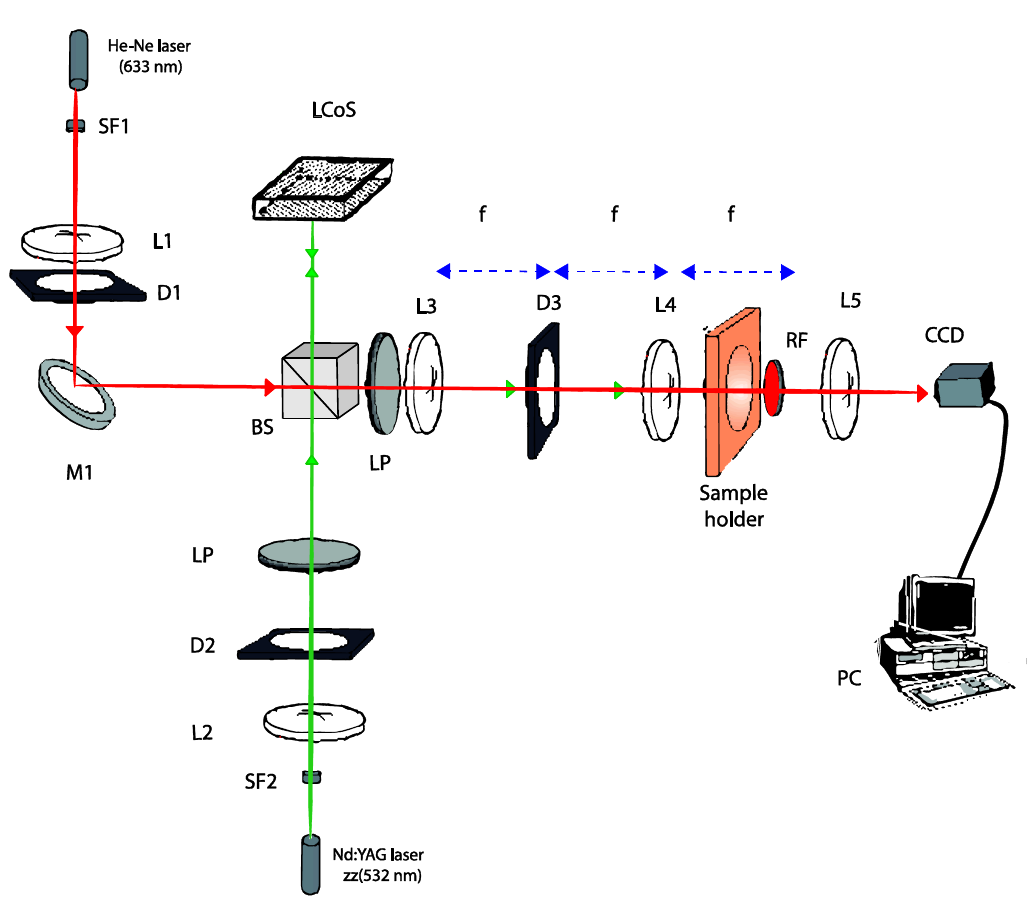
Figure 1. Experimental setup used to register and analyze in real-time the DOEs (blazed gratings): D, diaphragm; L, lens; BS, beam splitter; SF, spatial filter; LP, lineal polarizer; RF, red filter; M, mirror. The image obtained by the CCD camera located in the recording plane is shown in Figure 2a.